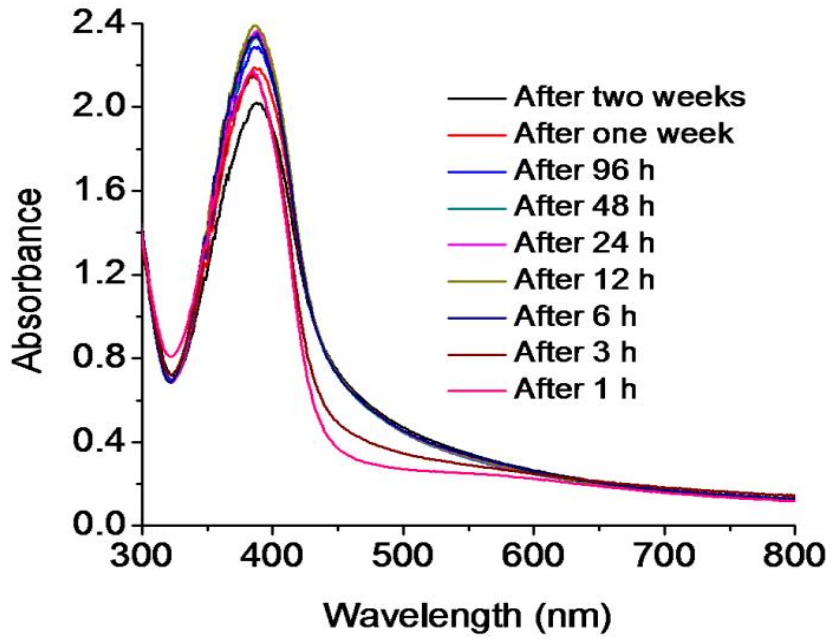
Figure 2. UV-visible spectra indicating the stability of mino/AgNPs.